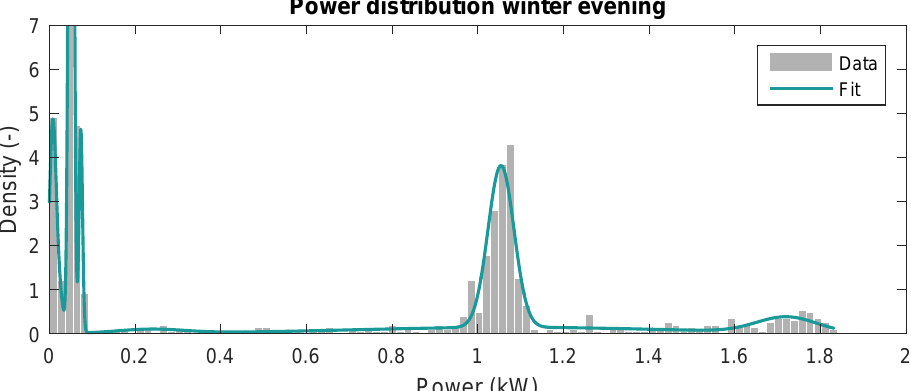
Figure 11. Measured and fitted PDF of heat pump electric load during winter evening, showing three peaks at the levels of power usage for the different operating